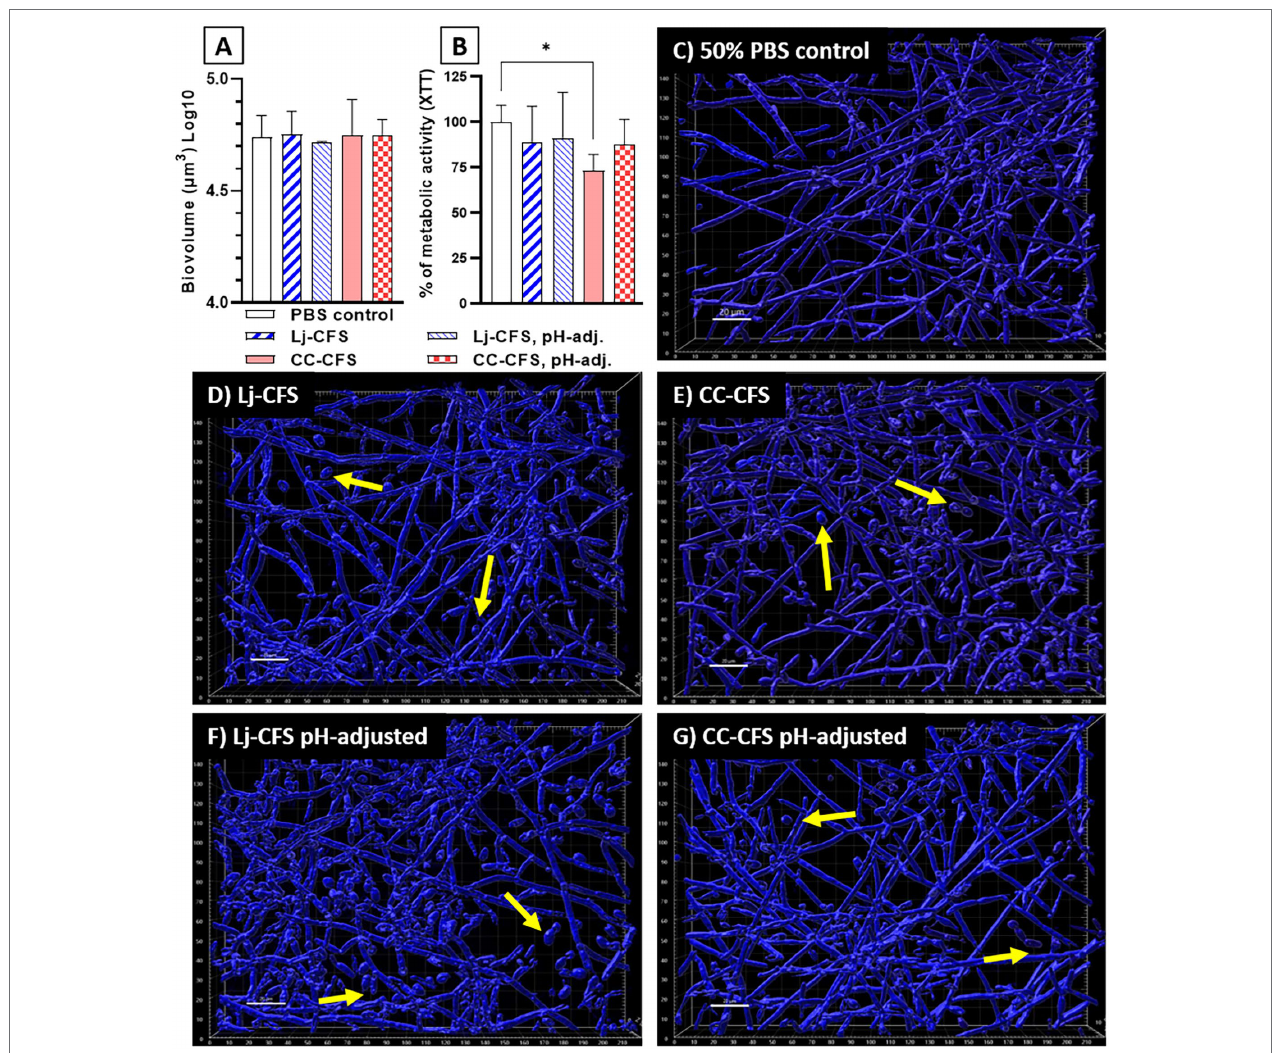
FIGURE 8 | Cell-Free Supernatants reduce the ability of C. albicans for hyphal transition in biofilm growth. CFS were prepared from single L. johnsonii biofilms (Lj-CFS, panels D,F ) or from biofilm cocultures with C. albicans (CC-CFS, panels E,G ) in biofilm media and were added during biofilm growth. CSF were used with and without pH neutralization to discern the metabolites’ activity beyond acidification. CFS did not reduce the fungal biofilm biovolumes (panel A ) but reduced the average metabolic activity of the biofilms (B) . Additionally, all CFS supplements notably increased the yeast morphotype numbers in biofilms. (C–G) . Yellow arrows indicate yeast cells. White bar = 20 μ . One-Way ANOVA, Dunnett posttest. * p ≤ 0.05. 100% of XTT metabolic activity (panel B) corresponds to OD 490 = 0.48 ± 0.05 SD of biofilms in 50%